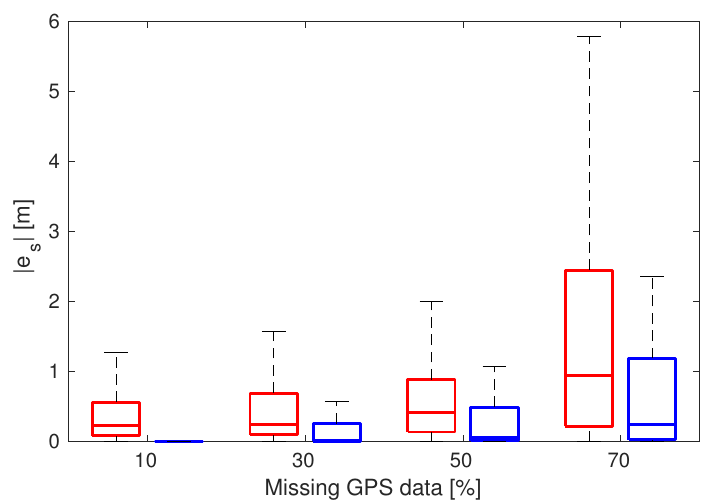
Figure 13. Absolute estimation error | e s | of the travelled distance s for different percentages of missing GPS data: without CAN (red boxes) and with CAN (blue